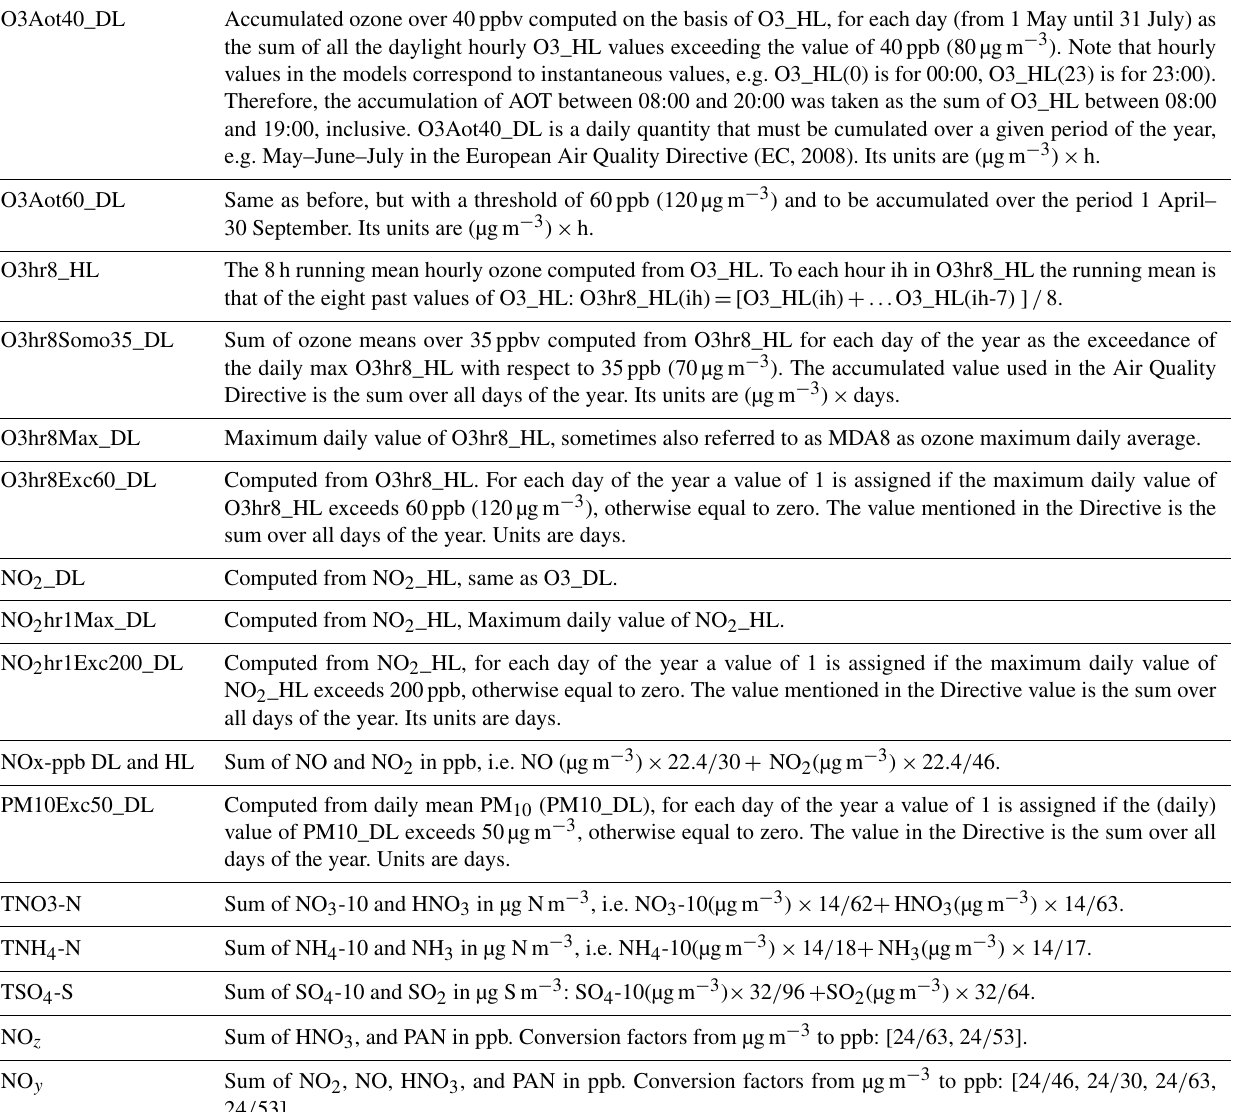
Table 5. List and definition of air pollution indicators derived from the model results and available in the project database. O3_DL Daily ozone computed on the basis of O3_HL as the mean value for each day between 00:00 and 23:00UTC. O3Aot40_DL Accumulated ozone over 40ppbv computed on the basis of O3_HL, for each day (from 1 May until 31 July) as the sum of all the daylight hourly O3_HL values exceeding the value of 40ppb (80µgm − 3 ). Note that hourly values in the models correspond to instantaneous values, e.g. O3_HL(0) is for 00:00, O3_HL(23) is for 23:00). Therefore, the accumulation of AOT between 08:00 and 20:00 was taken as the sum of O3_HL between 08:00 and 19:00, inclusive. O3Aot40_DL is a daily quantity that must be cumulated over a given period of the year, e.g. May–June–July in the European Air Quality Directive (EC, 2008). Its units are (µgm − 3 ) ×